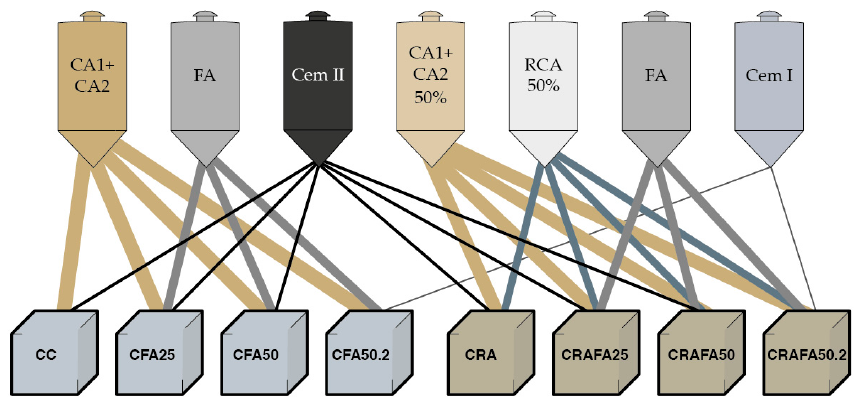
Figure 3. Description of materials employed and produced concrete. The eight concretes were produced in both